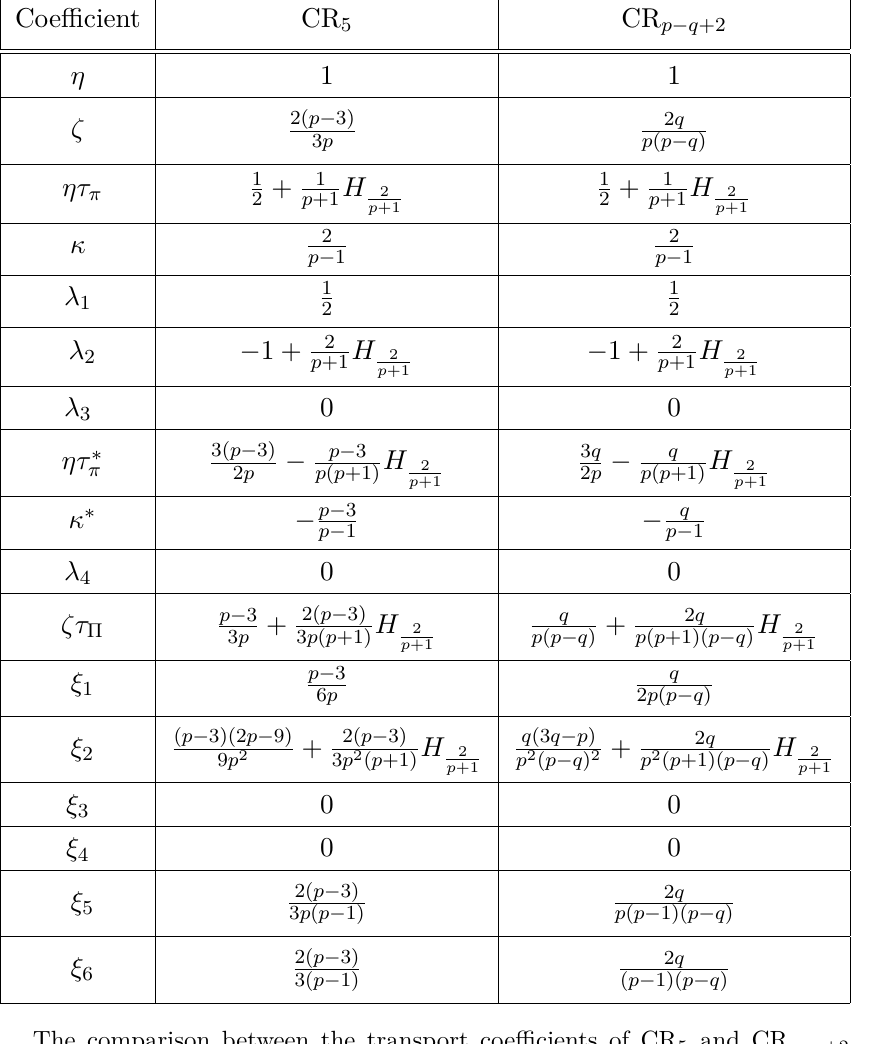
Table 2 . The comparison between the transport coefficients of CR 5 and CR p − q +2 , here the Chamblin-Reall backgrounds refer to the compactified AdS black